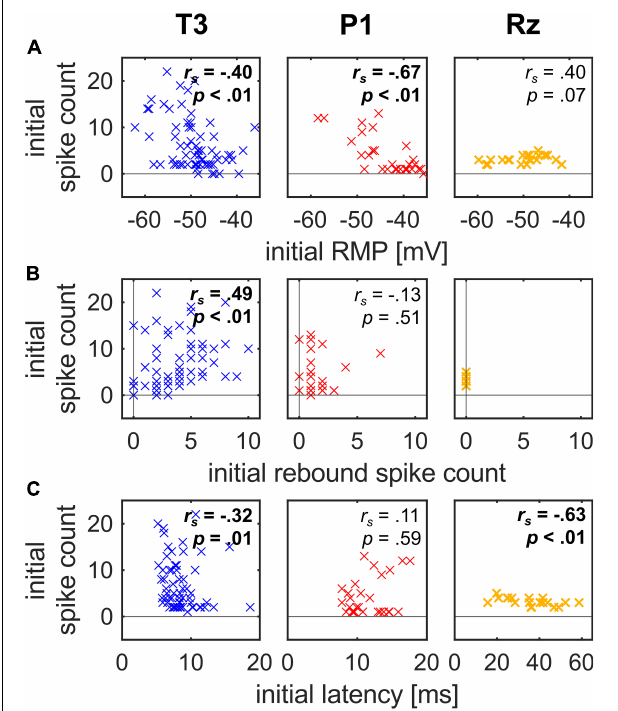
FIGURE 4 | Interdependencies between initial response features in the stimulation protocol for all three cell types. Significant correlations are marked in bold. Sample sizes, correlation coefficients and p -values are given in Table 1 . (A) The initial RMP correlated negatively with the initial spike count in T3 and P1 cells, but not in Rz cells. (B) The number of initial rebound spikes correlated positively with the initial spike count in T3 cells, but not in P1 cells. Rz cells did not show any rebound spikes. (C) The initial latency correlated negatively with the initial spike count in T3 and Rz cells, but not in P1 cells. Note that the few T3 and P1 cells with zero initial spikes by definition do not have a response latency and are therefore not included in these plots (see Table 1 for sample